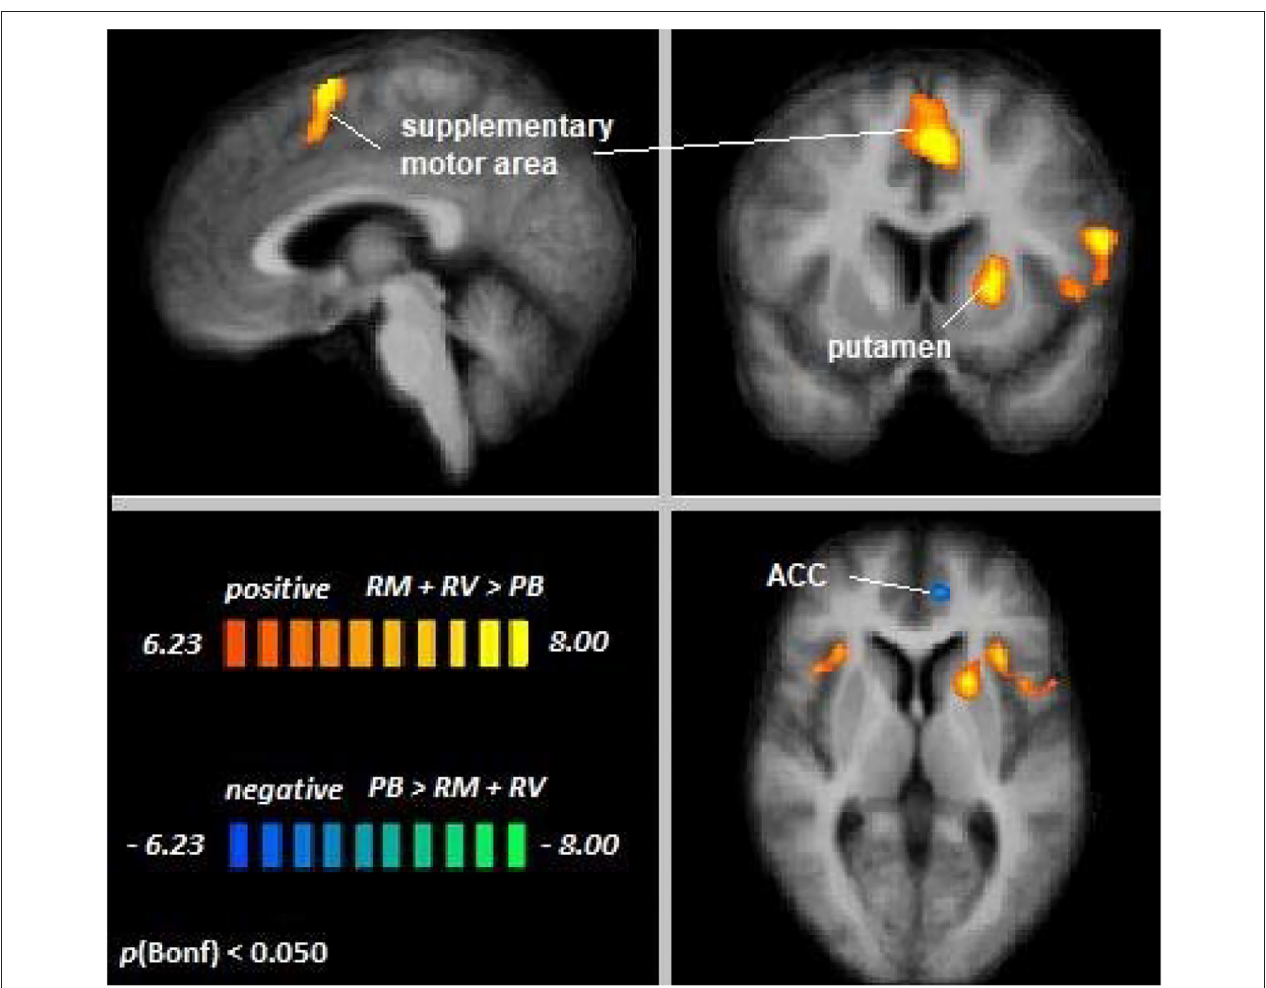
FIGURE 4 | Remember music and remember voices vs. passive baseline. An overview of significant clusters for the contrast RF + RS > PB. Sagittal, coronal, and axial planes are shown at x = 3, y = 6, z = 2. Orange to yellow clusters indicate voxels with greater activation in auditory selective attention conditions relative to baseline. Blue to green clusters reveal voxels with lower activation in auditory selective attention conditions relative to baseline.